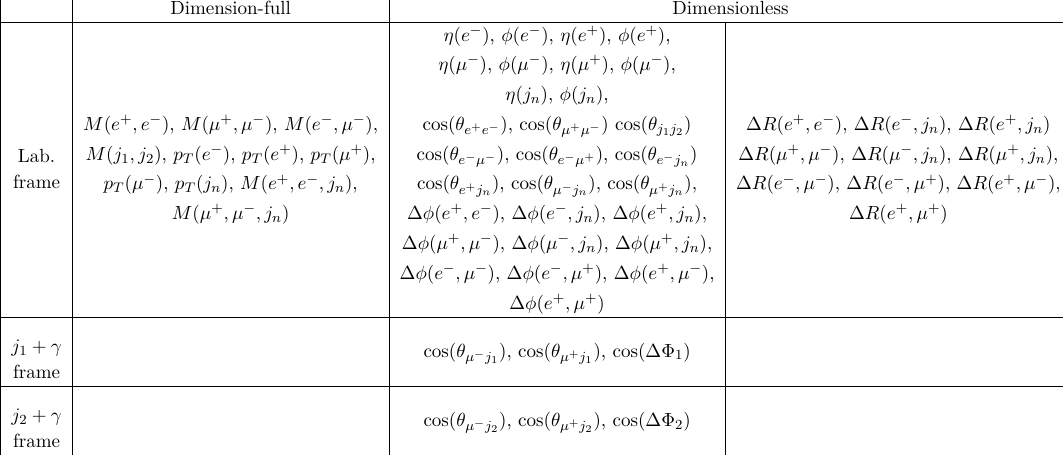
Table 5. Angular and kinematic observables selected for study of VLQ pair-production, for different frames of reference, the laboratory frame (in the first row), j 1 + γ and j 2 + γ frames (in the second and third row, respectively). The same nomenclature of table 3 for angles applies here. ∆Φ 1 , 2 corresponds to the azimuthal angle formed by the decay planes of the two virtual photons. To simplify notation, it is defined j n = j 1 , j 2